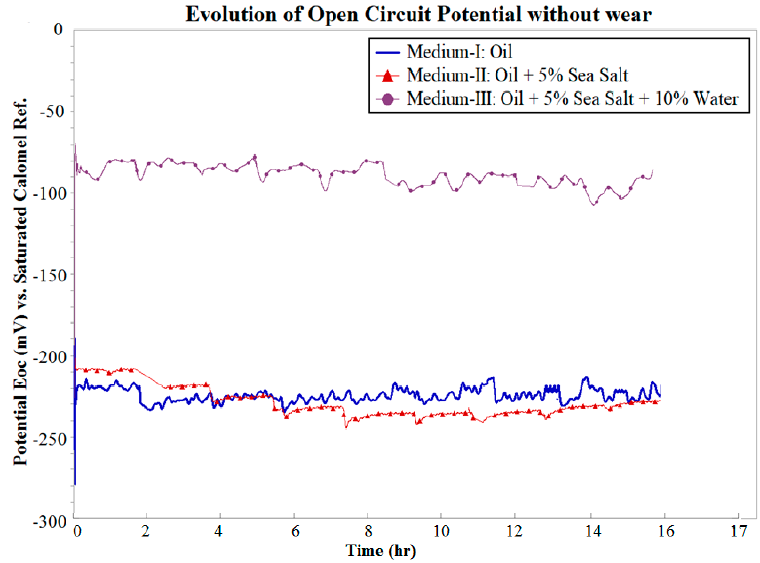
Figure 6. Evolution of OCP without wear.